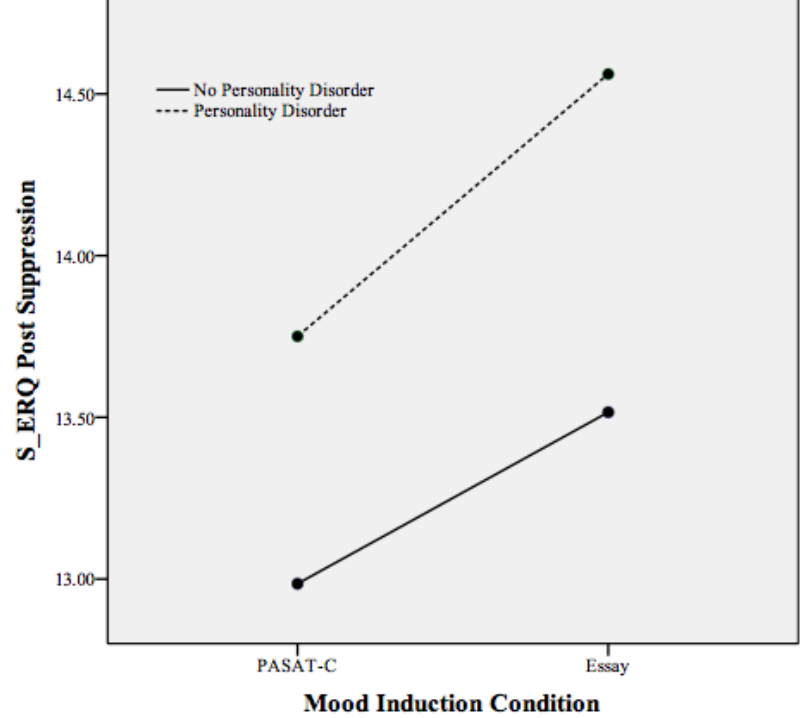
Figure 7. Plot of the non-statistically significant trends in the relationship between mood induction condition, personality disorder, and suppression scale of the S-ERQ following both mood inductions. Higher scores indicate more use of